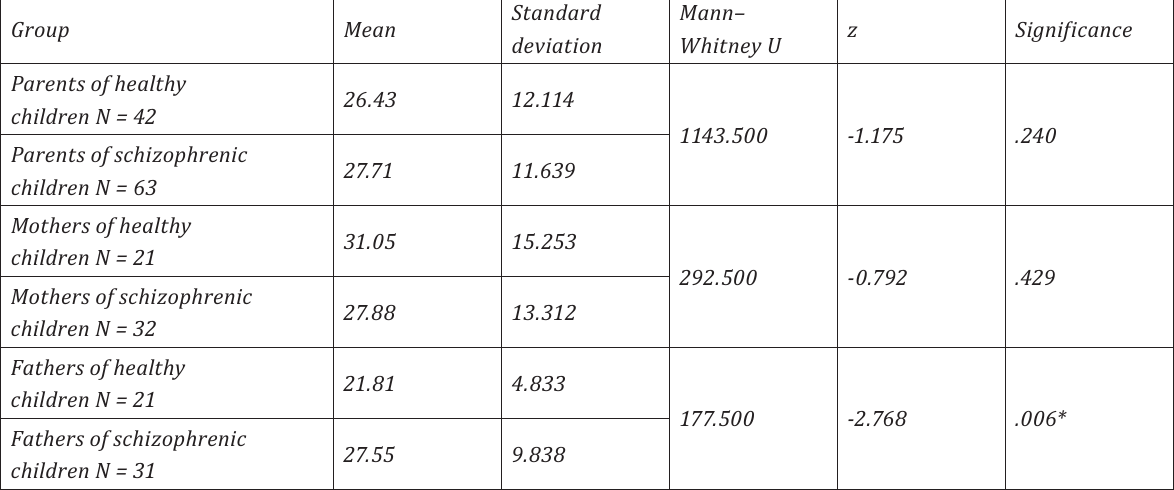
Table 1. Mean number of responses, standard deviations, and the significance of differences between the groups of